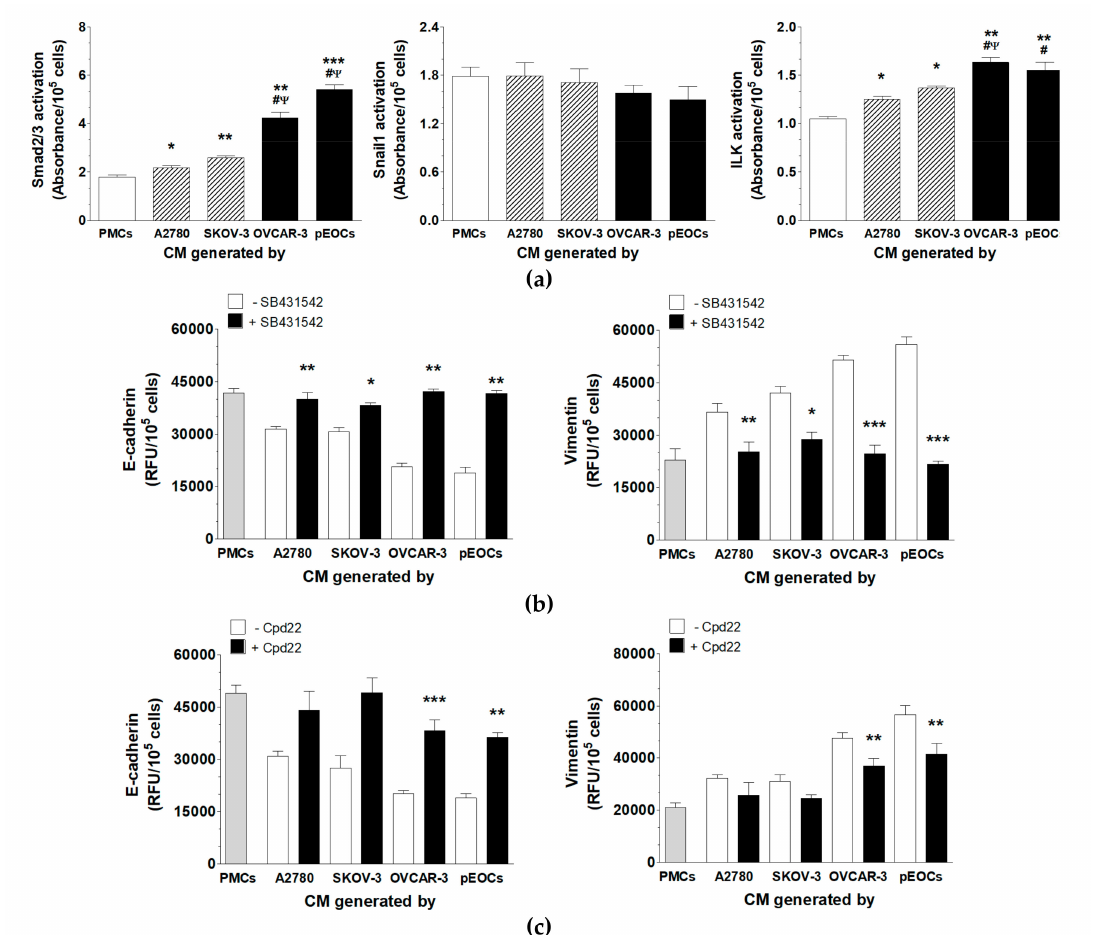
Figure 4. Signaling pathways involved in the cancer-induced MMT in PMCs. ( a ) Activation of Smad 2 / 3, Snail1, and ILK in the PMCs exposed to autologous and cancer-derived CM. Expression of E-cadherin and vimentin in the PMCs preincubated with chemical inhibitors of Smad 2 / 3 (SB431542) ( b ) and ILK (Cpd22) ( c ) prior to their exposure to autologous and cancer-derived CM. Experiments were performed with eight separate cultures of PMCs obtained from di ff erent donors, with eight separate cultures of primary epithelial cancer cells (pEOC), and with eight separate cultures of each established cancer cell line. Results are expressed as the mean ± SEM. *, p < 0.05 vs. PMCs; **, p < 0.01 vs. PMCs; ***, p < 0.001 vs. PMCs; # , p < 0.05 vs. A2780; Ψ , p < 0.05 vs. SKOV-3. RFU, relative fluorescence